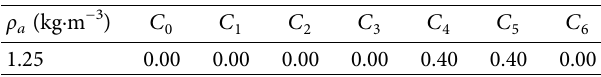
Table 5: Parameters for air and state